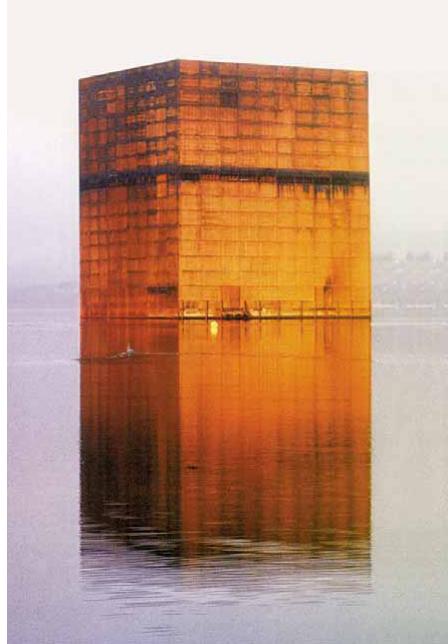
Fig. 11. Expo 2002; Murten-Morat,